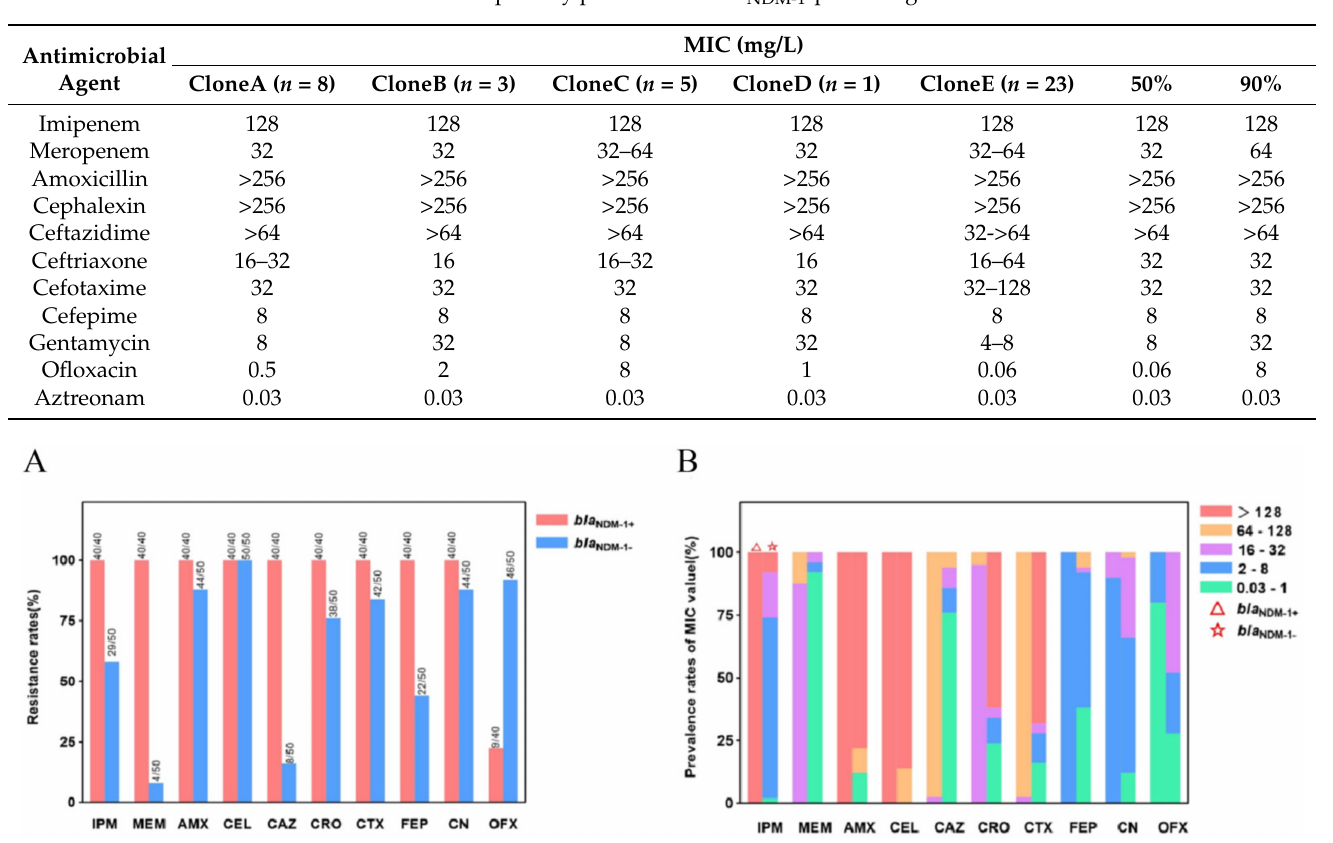
Table 1. Antimicrobial susceptibility patterns of 40 bla NDM-1 -producing P. mirabilis isolates.